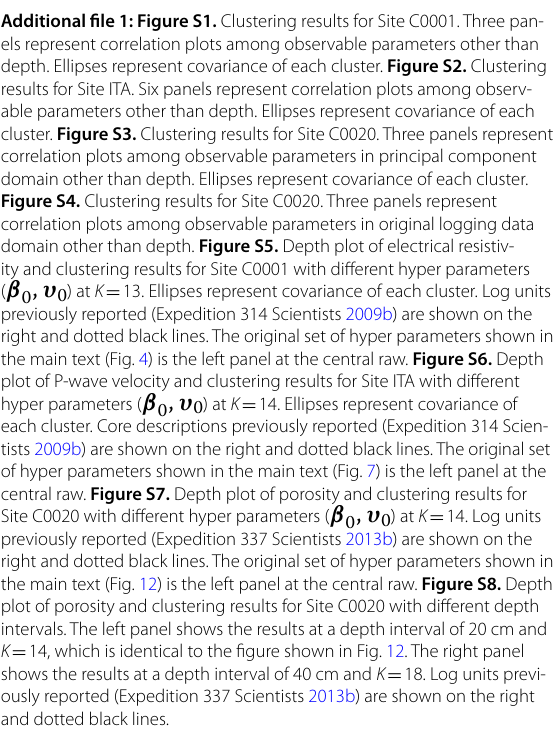
Figure S4. Clustering results for Site C0020. Three panels represent correlation plots among observable parameters in original logging data domain other than depth. Figure S5. Depth plot of electrical resistiv‑ ity and clustering results for Site C0001 with different hyper parameters ( β 0 , υ 0 ) at K 13. Ellipses represent covariance of each cluster. Log units = previously reported (Expedition 314 Scientists 2009b) are shown on the right and dotted black lines. The original set of hyper parameters shown in the main text (Fig. 4) is the left panel at the central raw. Figure S6. Depth plot of P‑wave velocity and clustering results for Site ITA with different hyper parameters ( β 0 , υ 0 ) at K 14. Ellipses represent covariance of = each cluster. Core descriptions previously reported (Expedition 314 Scien‑ tists 2009b) are shown on the right and dotted black lines. The original set of hyper parameters shown in the main text (Fig. 7) is the left panel at the central raw. Figure S7. Depth plot of porosity and clustering results for Site C0020 with different hyper parameters ( β 0 , υ 0 ) at K 14. Log units = previously reported (Expedition 337 Scientists 2013b) are shown on the right and dotted black lines. The original set of hyper parameters shown in the main text (Fig. 12) is the left panel at the central raw. Figure S8. Depth plot of porosity and clustering results for Site C0020 with different depth intervals. The left panel shows the results at a depth interval of 20 cm and K 14, which is identical to the figure shown in Fig. 12. The right panel = shows the results at a depth interval of 40 cm and K 18. Log units previ‑ = ously reported (Expedition 337 Scientists 2013b) are shown on the right and dotted black